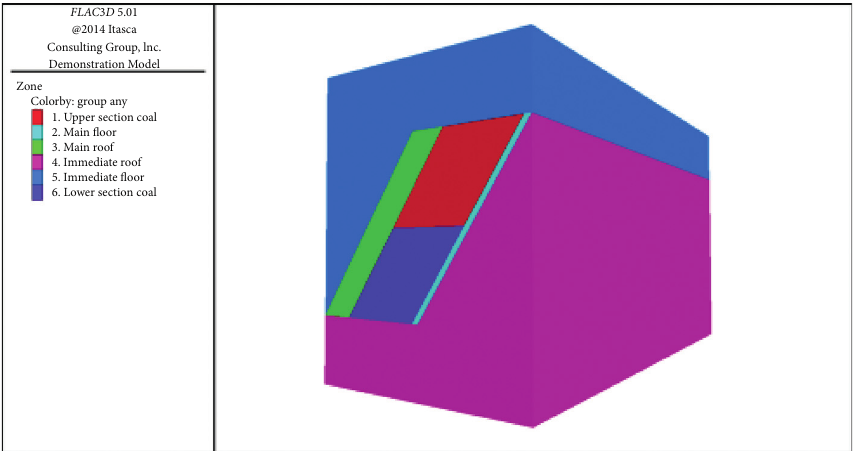
Figure 12: Numerical calculation model.